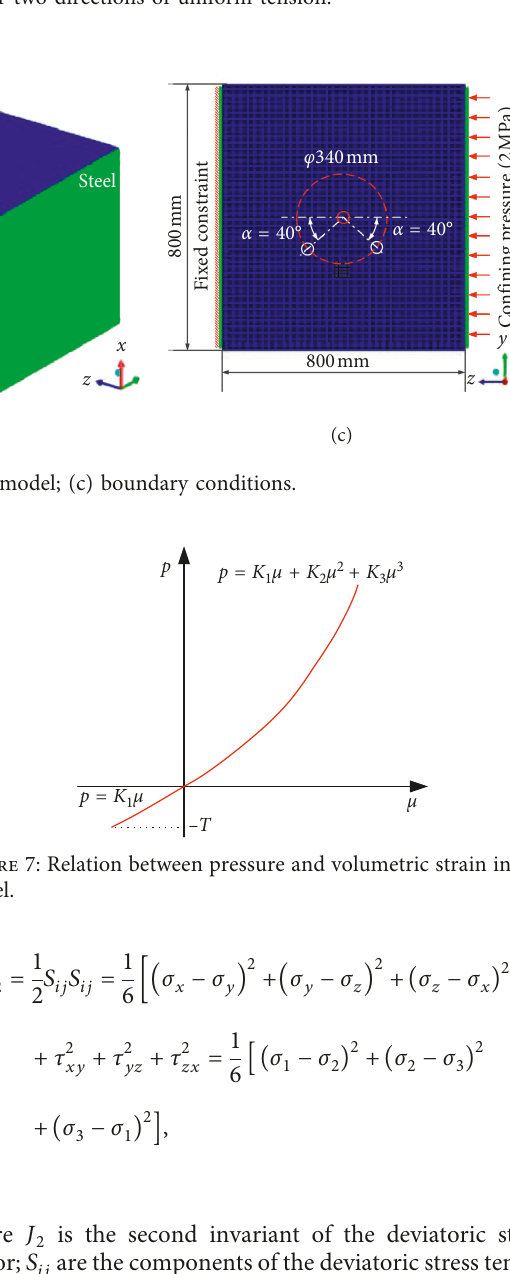
Figure 5: Superposition model of stress field under two directions of uniform